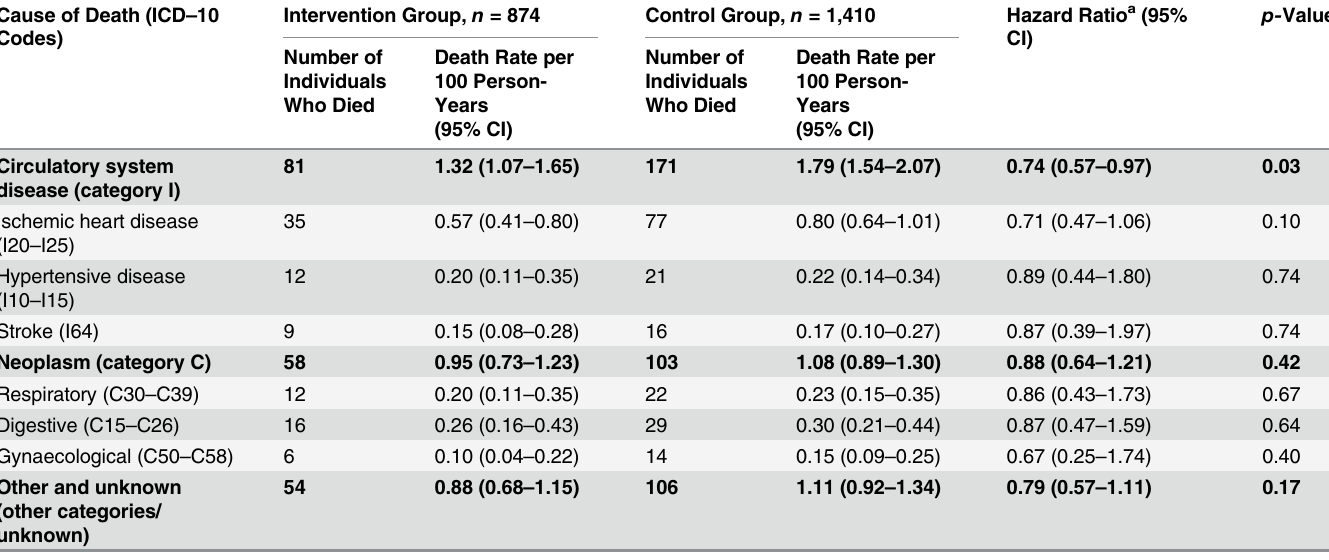
Table 5. Secondary outcome at 8-y follow-up: mortality rates for main causes and sub-causes of